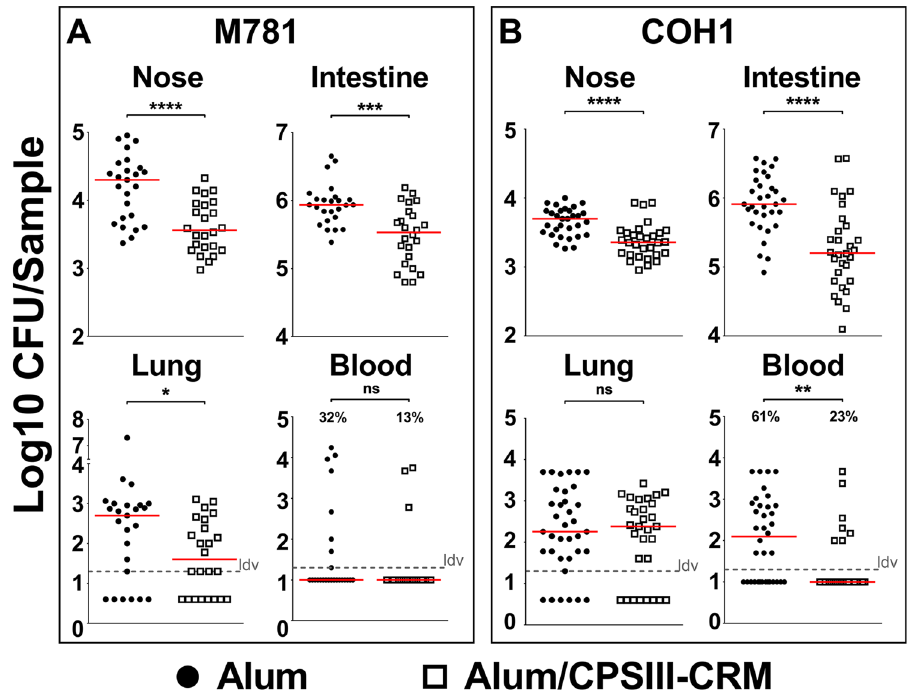
Figure 3. Pups from vaccinated mothers were protected against GBS colonization and deeper infection. CFU counts in nasal washes (Nose), intestinal homogenates (Intestine), lung and blood of mouse neonates from mothers immunized with alum/CPSIII-CRM or alum alone seven days after intranasal challenge with GBS serotype III strains M781 ( A ) or COH1 ( B ). Data from 24 to 30 mice/group and two–three independent experiments are reported for each strain tested. Each dot represents a single animal and the red horizontal line is the median value of the group. In the graphs reporting data from the blood, the percentage of pups experiencing bacteremia are also shown. When present, the grey dotted horizontal line depicts the lowest detectable value (ldv). *P < 0.05; **P < 0.01; ***P < 0.001; ****P < 0.0001 (Mann–Whitney U test or Fisher’s exact test for blood only).